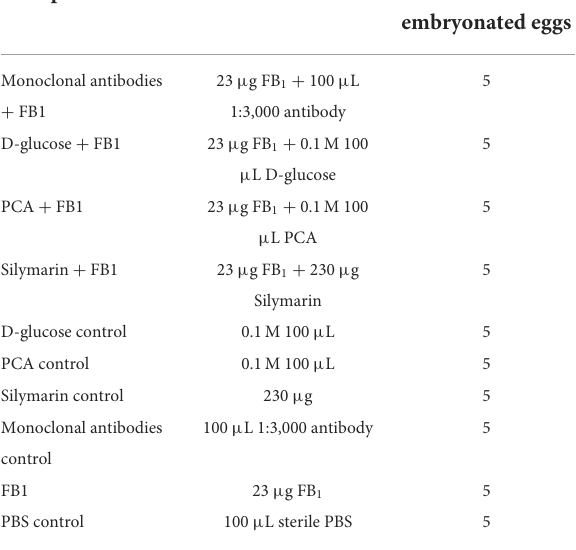
TABLE 1 Experimental protocol of detoxification in embryonated eggs. Groups Treatment No.